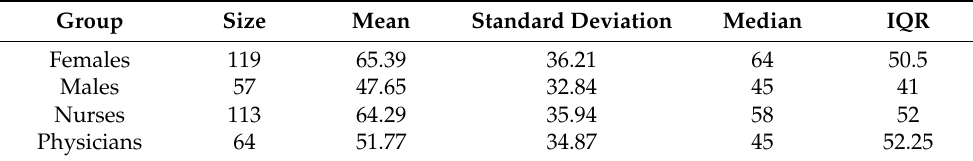
Table 3. Descriptive statistics for relevant socio-demographic